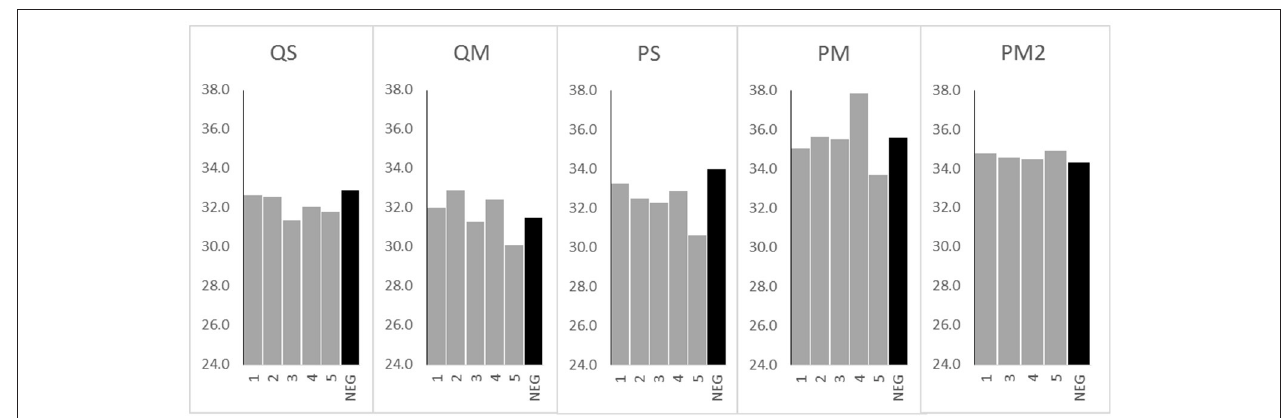
FIGURE 2 | 16S rRNA gene Ct values from meconium samples ( n = 5 for kits QS, QM, PS, and PM, n = 4 for kit PM2) and negative extraction controls (NEG) ( n = 1 per kit) processed with various extraction kits. Sample numbers (1–5 or NEG) are displayed on the x axis. Ct values are displayed on the y axis.